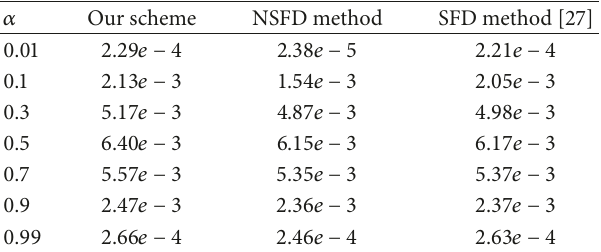
Figure 4: Error norm 𝐿 ∞ for Example 8 ( 𝛼 = 0.8 −◻ ; 𝛼 = 0.9 − ∘ ; and 𝛼 = 0.95 − × ) at 𝑇 = 1 . Table 7: Maximum norm relative errors of the proposed approximate-analytical solution, NSFD method, and SFD technique for Example 8.